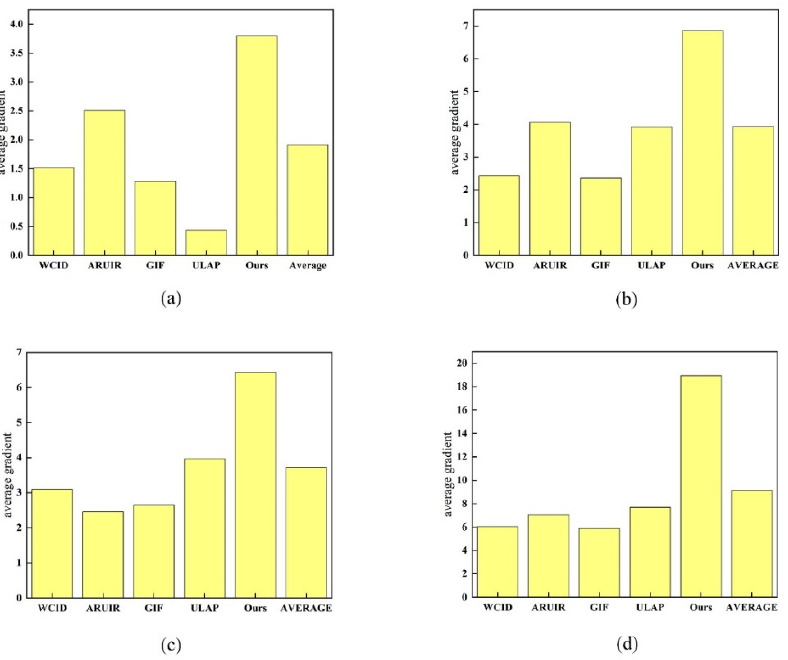
Figure 9. ( a ) Figure 5a uses the AG values of different algorithms, ( b ) Figure 6a uses the AG values of different algorithms, ( c ) Figure 7a uses the AG values of different algorithms and ( d ) Figure 8a uses the AG values of different algorithms.